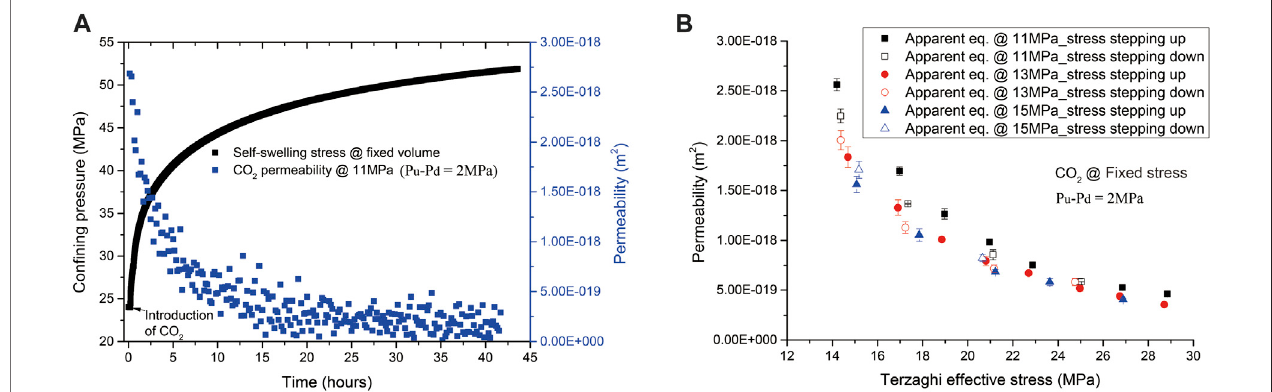
FIGURE 5 | Development of CO 2 permeability and the con fi ning pressure versus time obtained under the fi xed volume boundary condition, illustrated in (A,B) showing development of CO 2 permeability versus Terzaghi effective stress performed under the fi xed stress boundary condition. Note that the scattered permeability data points shown in (A) re fl ect the noise caused by data processing via moving average at low permeability ( < 10 − 18 m 2 ) using the steady-state